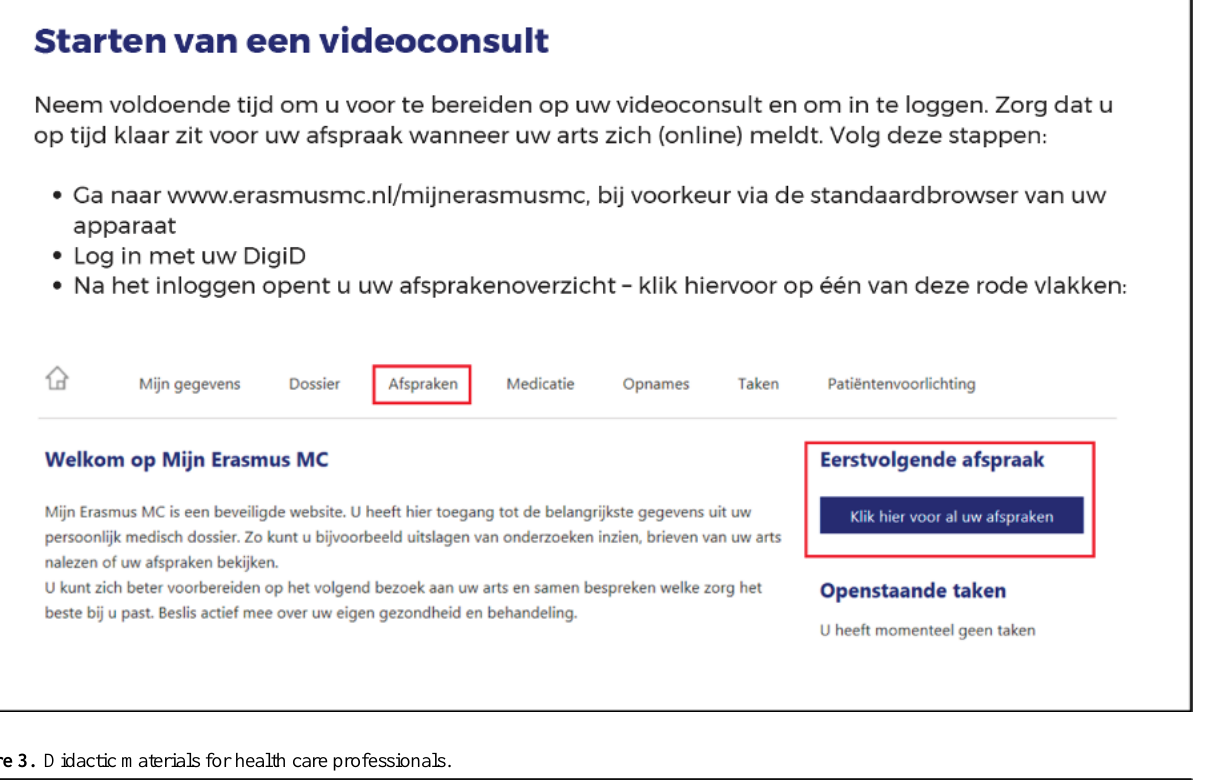
Figure 2. Didactic materials for patients.